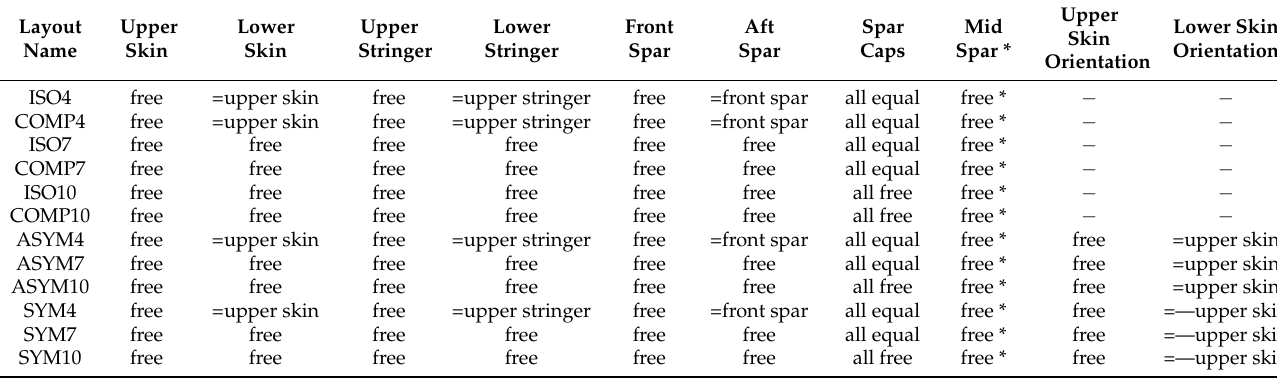
Table 1. Available section variable linking (* if intermediate spars are present).